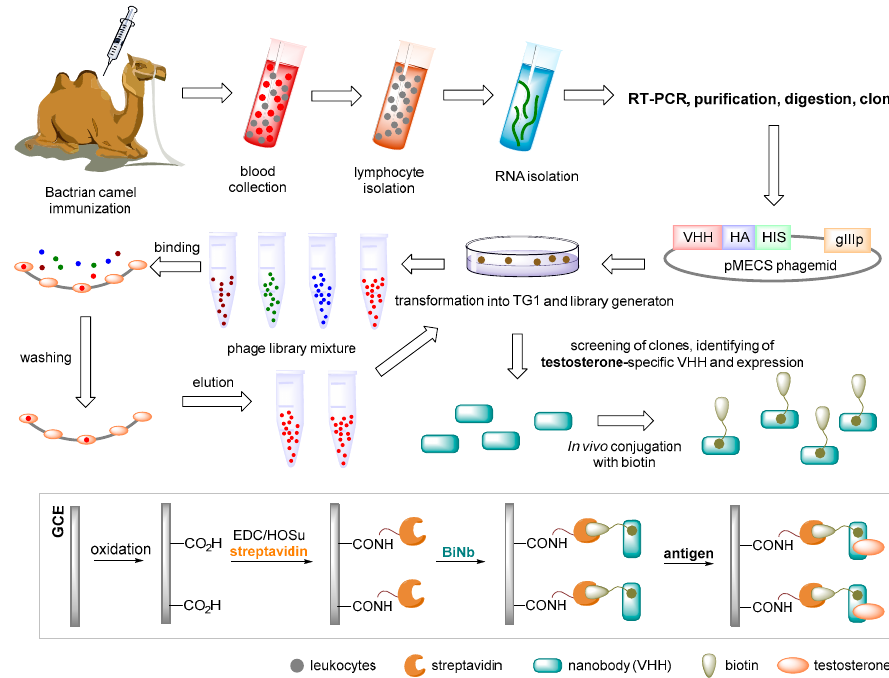
Figure 5. The anti-testosterone nanobody identification process. Bactrian camel immunization, VHH (nanobody, the antigen-binding fragment of heavy-chain-only antibodies), phage display li- brary construction; biopanning, expression, and purification of soluble nanobodies (Nbs); a thermo- stability experiment; solvent effect; surface plasmon resonance affinity detection; biotinylation of a nanobody in vivo (BiNb), and development of a nanobody-based electrochemical immunosensor (i.e., immunogen or preparation, GCE: glassy carbon electrode, EDC: 1-ethyl-3-(3- dimethylaminopropyl)carbodiimide, HOSu: N -hydroxysuccinimide; cyclic voltammetry and electro- chemical impedance spectroscopy measurements). RT-PCR: real-time polymerase chain reaction